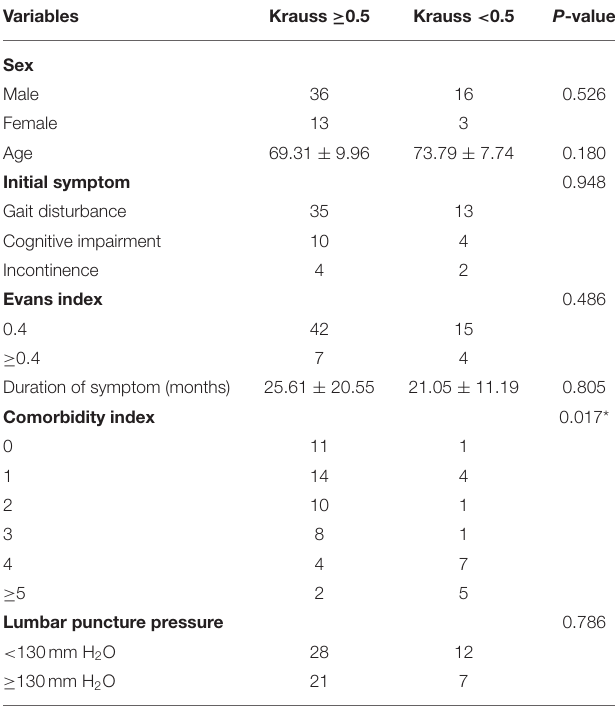
TABLE 3 | Patient’s characteristics and predictors of VP-shunt outcome.